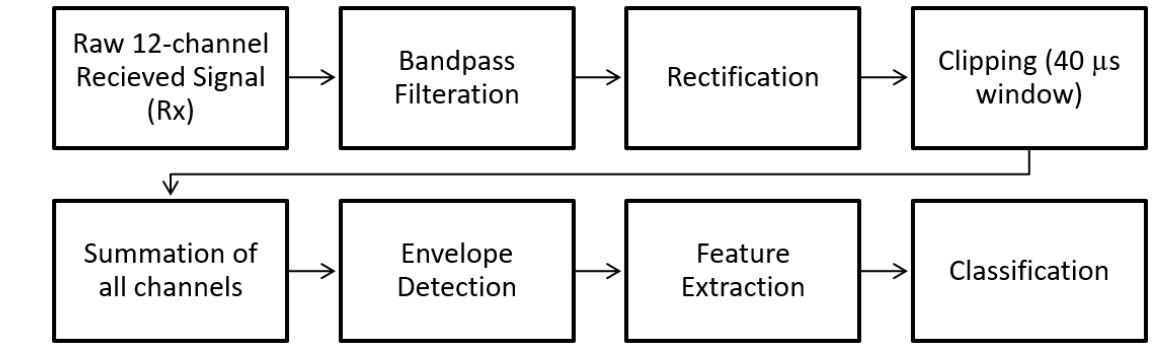
Figure 7. Block diagram showing the post-processing steps.